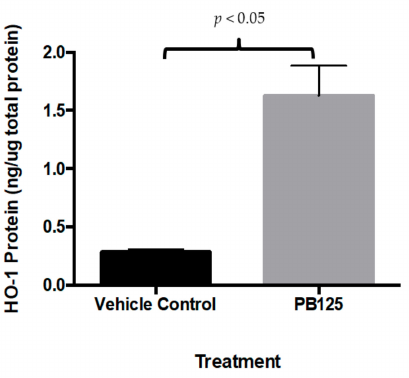
Figure 3. HMOX1 protein was increased by PB125. Treatment of HepG2 cells with PB125 increased the levels of HMOX1 protein determined by ELISA, as expected based on the large PB125-induced increase in HMOX1 gene expression measured by microarray, quantitative PCR, and RNA-seq methods.